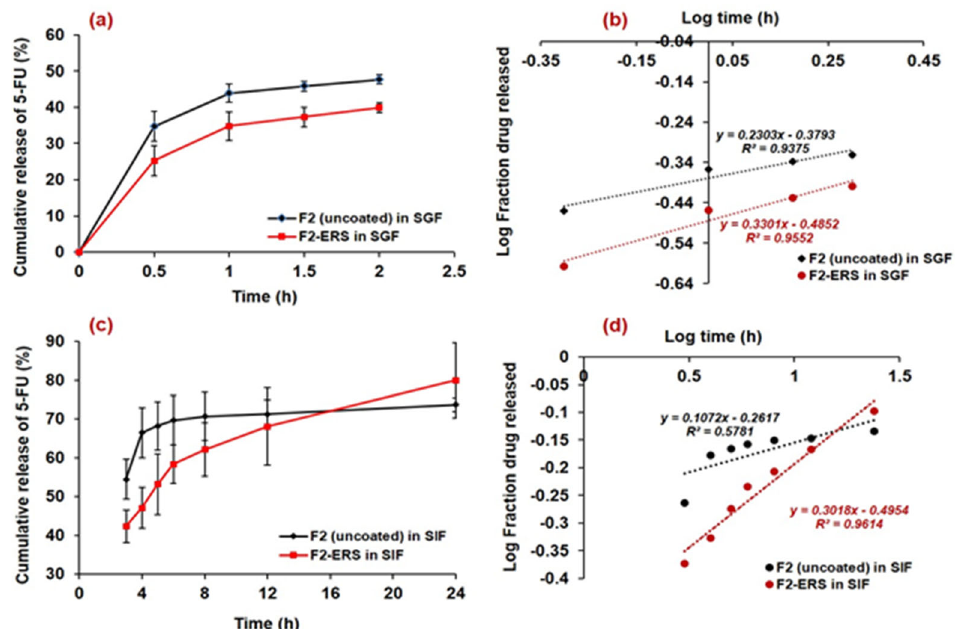
Figure 7. In vitro release profiles of 5 ‐ FU ‐ loaded spores (uncoated and ERS ‐ coated) in SGF ( a ); Korsmeyer–Peppas plots in SGF ( b ); release profiles of 5 ‐ FU ‐ loaded spores (uncoated and ERS ‐ coated) in SIF ( c ); and release kinetics model (Korsmeyer–Peppas) plots in SIF ( d ).